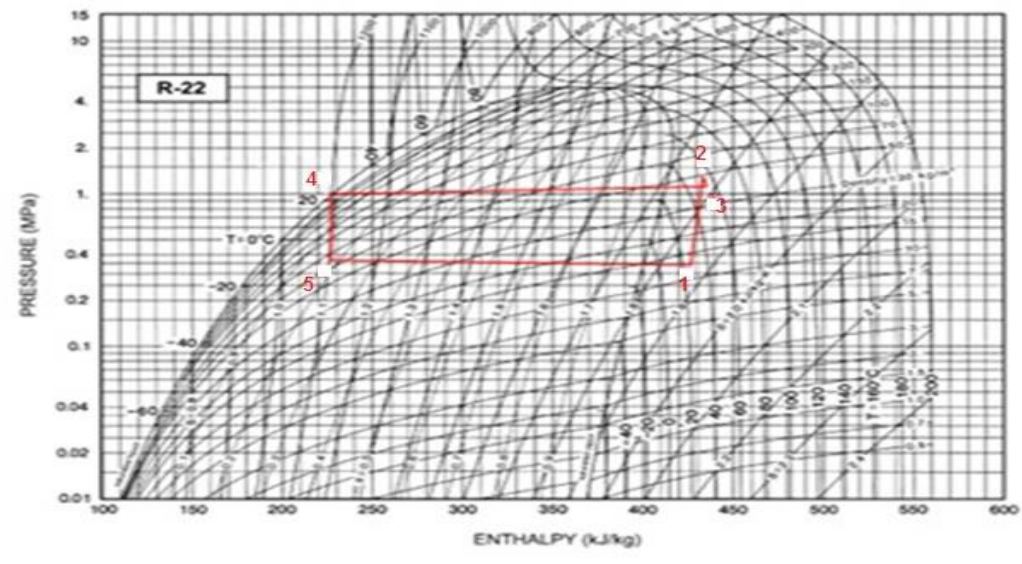
Fig.13: P-h chart without water